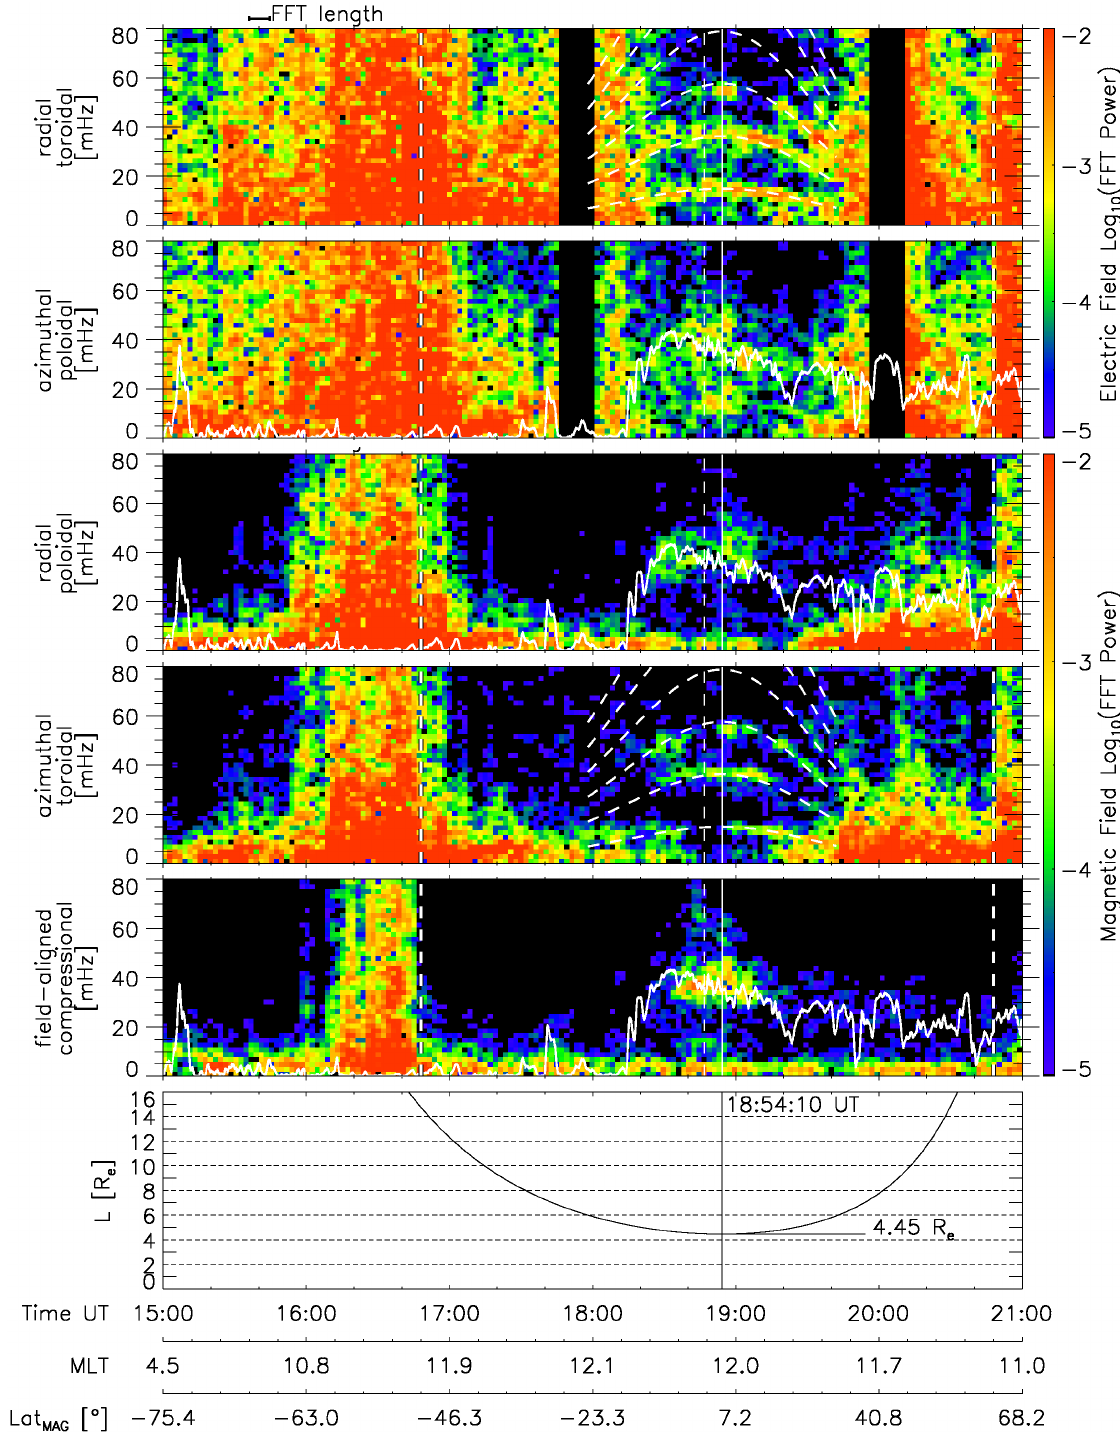
Fig. 6. Same format as Fig. 4, but s/c 3 data on 05 September 2002.